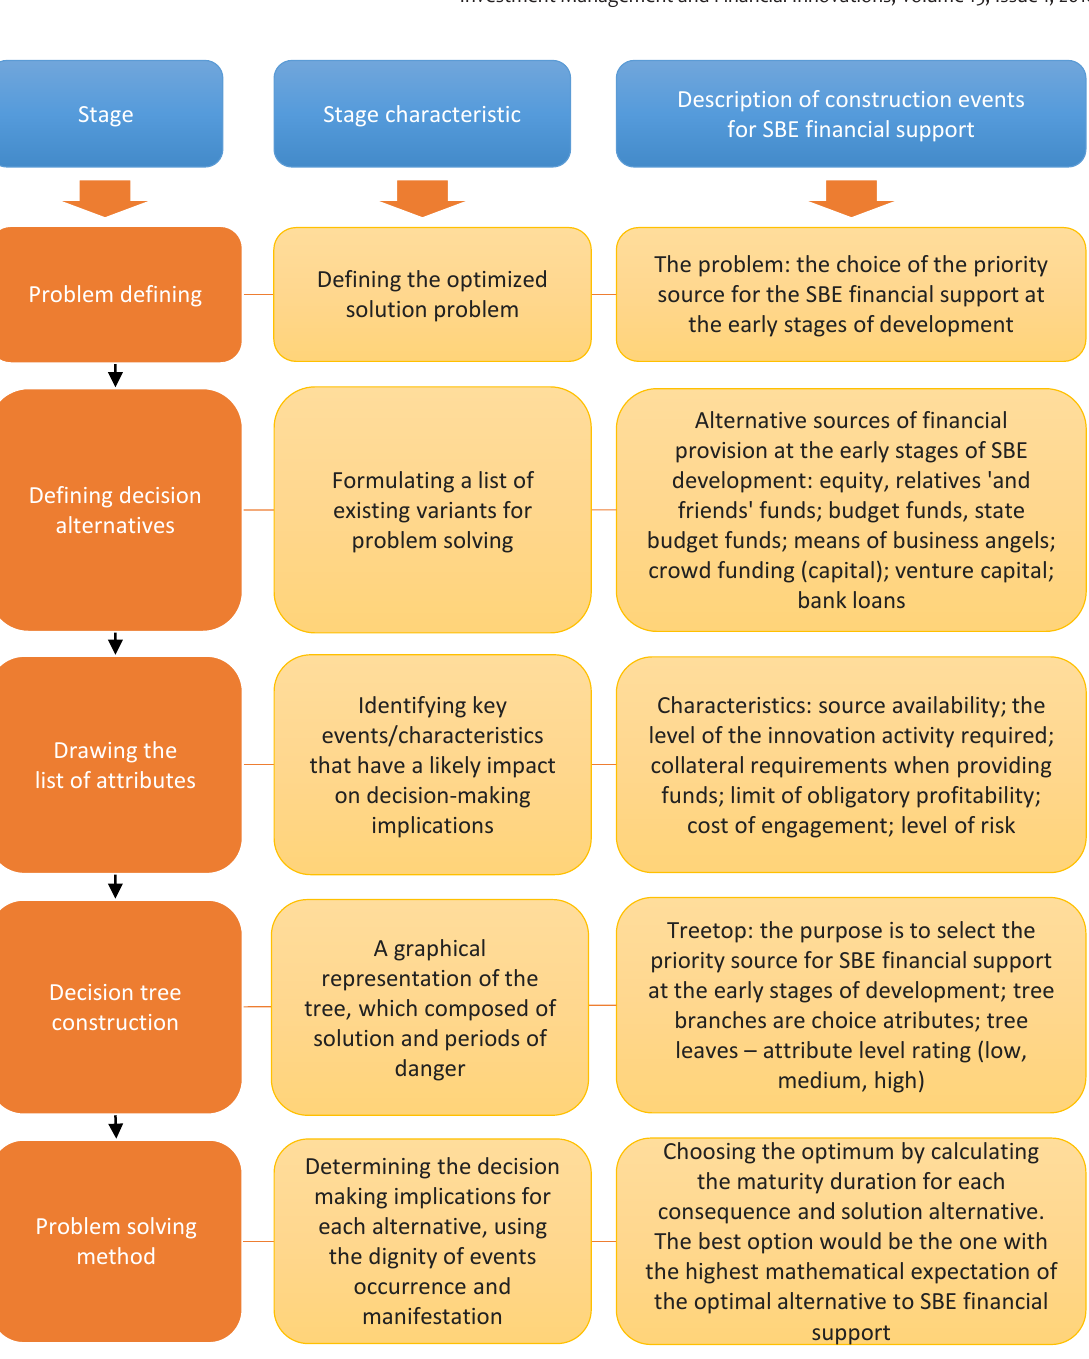
Figure 7. Decision tree algorithm for attracting an optimal